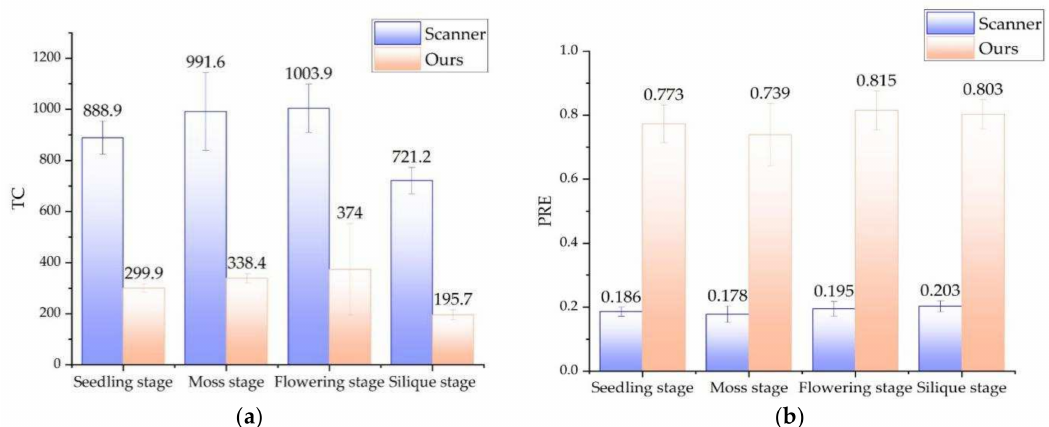
Figure 14. Comparison of resolution and time consuming between a laser scanner and our method. ( a ) Comparison of the TC. ( b ) Comparison of the PRE. Note: TC: Time consumption (Second), PRE: Precision